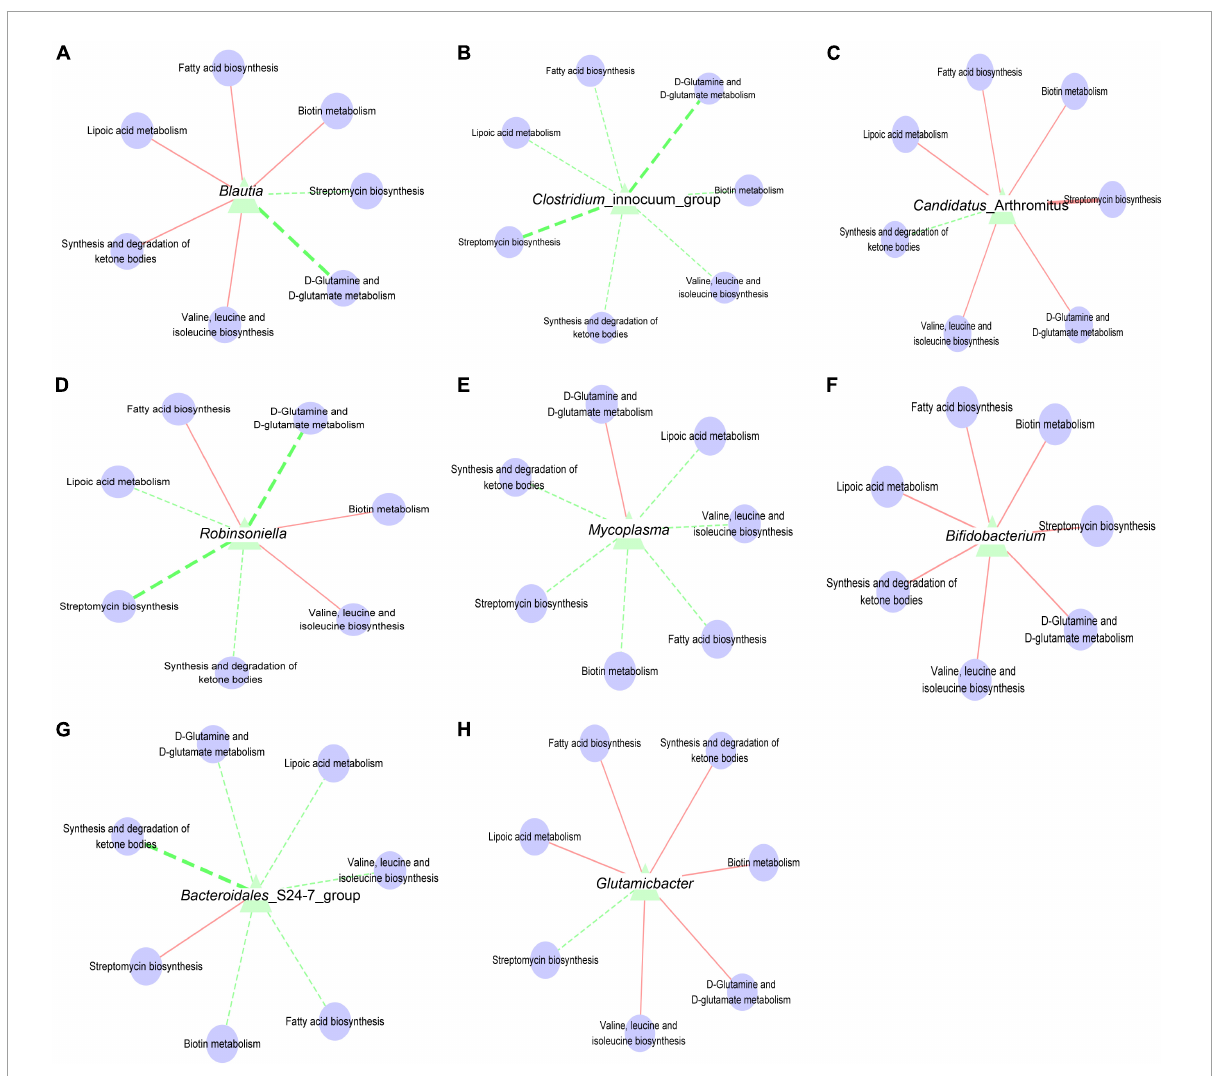
FIGURE7 (A) Interaction network of “ Blautia -metabolic function”. (B) Interaction network of “ Clostridium _innocuum_group-metabolic function”. (C) Interaction network of “ Candidatus _Arthromitus-metabolic function”. (D) Interaction network of “ Robinsoniella -metabolic function”. (E) Interaction network of “ Mycoplasma -metabolic function”. (F) Interaction network of “ Bifidobacterium -metabolic function”. (G) Interaction network of “ Bacteroidales _S24-7_group-metabolic function”. (H) Interaction network of “ Glutamicibacter -metabolic function”. The solid line represented a positive correlation; the dotted line represented a negative correlation. The thickness of the line indicated the strength of the